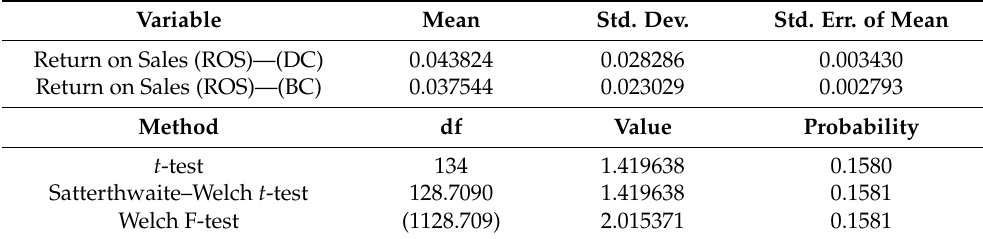
Table 4. The result of